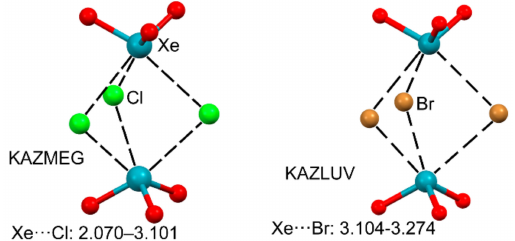
Figure 11. Partial views of the X-ray structures corresponding to Cambride structural database (CSD) reference codes KAZMEG ( left ) and KAZLUV ( right ) corresponding to tris(tetraethylammonium), tris( µ -chloro)-( µ -oxo)-octaoxo-tri-xenon, and tris(tetraethylammonium), tris( µ -bromo)-( µ -oxo)-octaoxo-tri-xenon acetonitrile solvate, respectively. Distances in Å. Counter-cations and solvent molecules omitted for